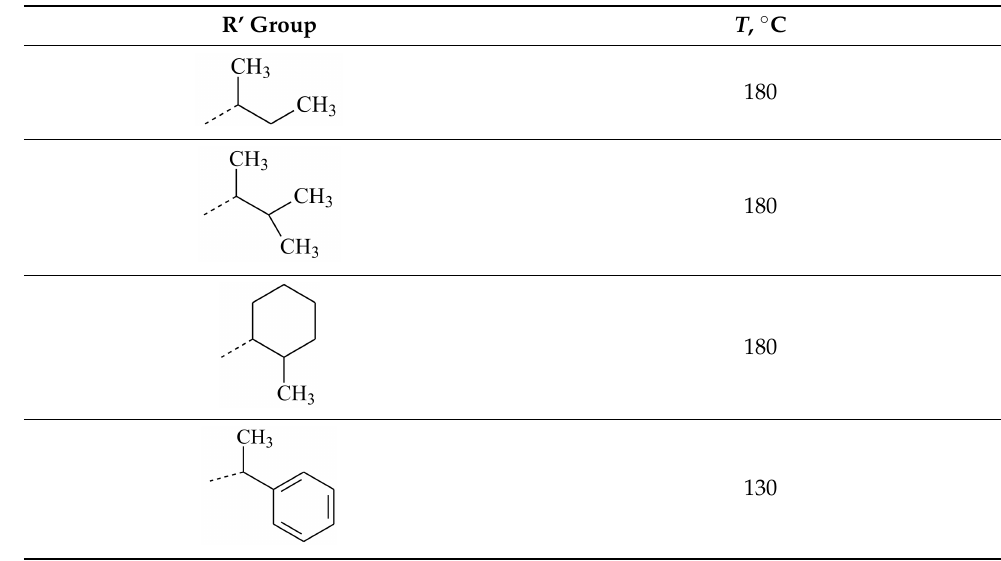
Table 3. The temperature of 100% RSH formation in xanthate-terminated poly(dimethyl siloxane) bearing different terminal xanthate –SC(=S)OR’